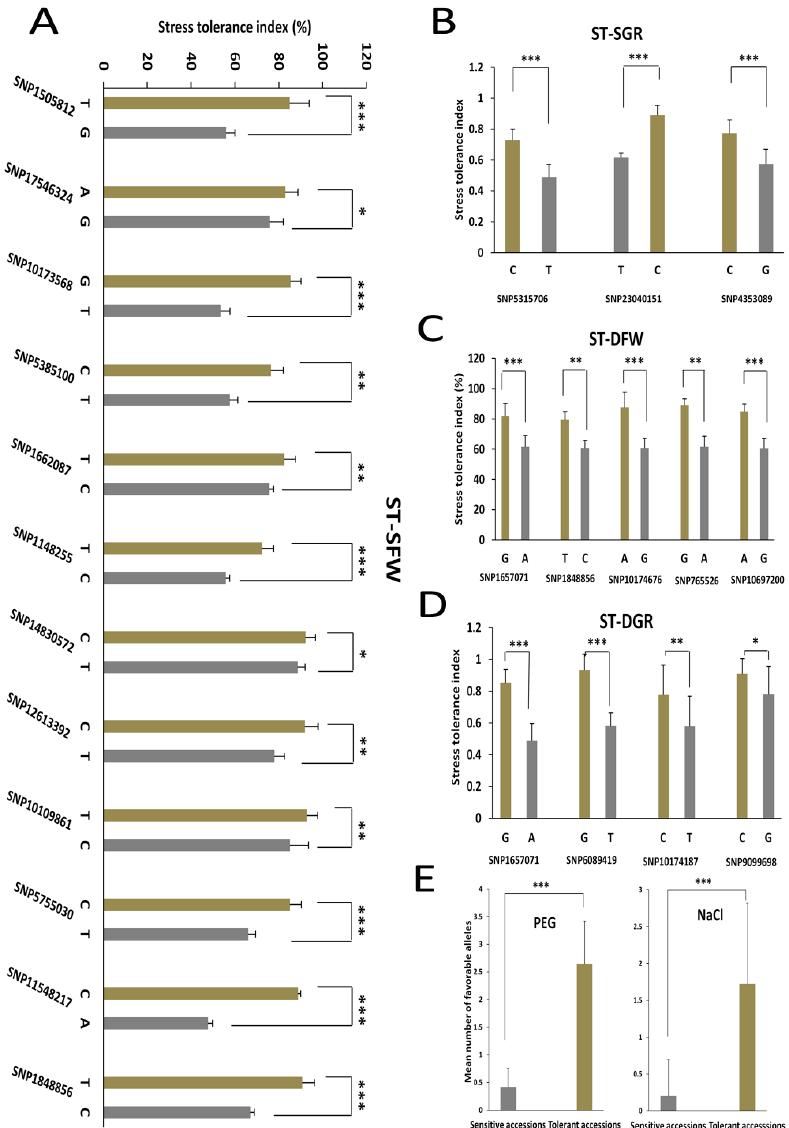
Figure 6. Allelic effects of the peak SNPs on NaCl-induced salt stress and PEG-induced drought tolerance indexes. ( A ) ST-SFW (%); ( B ) ST-SGR; ( C ) ST-DFW (%); ( D ) ST-DGR; ( E ) Mean number of favorable alleles identified in the tolerant and sensitive accessions to drought and salt stresses. *, **, *** significant difference at p < 0.05, p < 0.01, p < 0.001, respectively. For each SNP, the first allele is the reference allele and the second allele is the variant. Gray bars represent the favorable allele while the green bars represent the unfavorable allele. Error bars represent standard deviation.